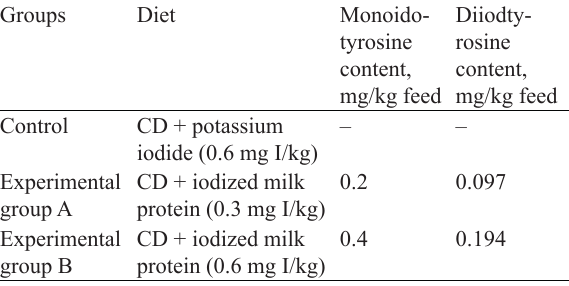
Table 2 Experiment scheme (stage II)